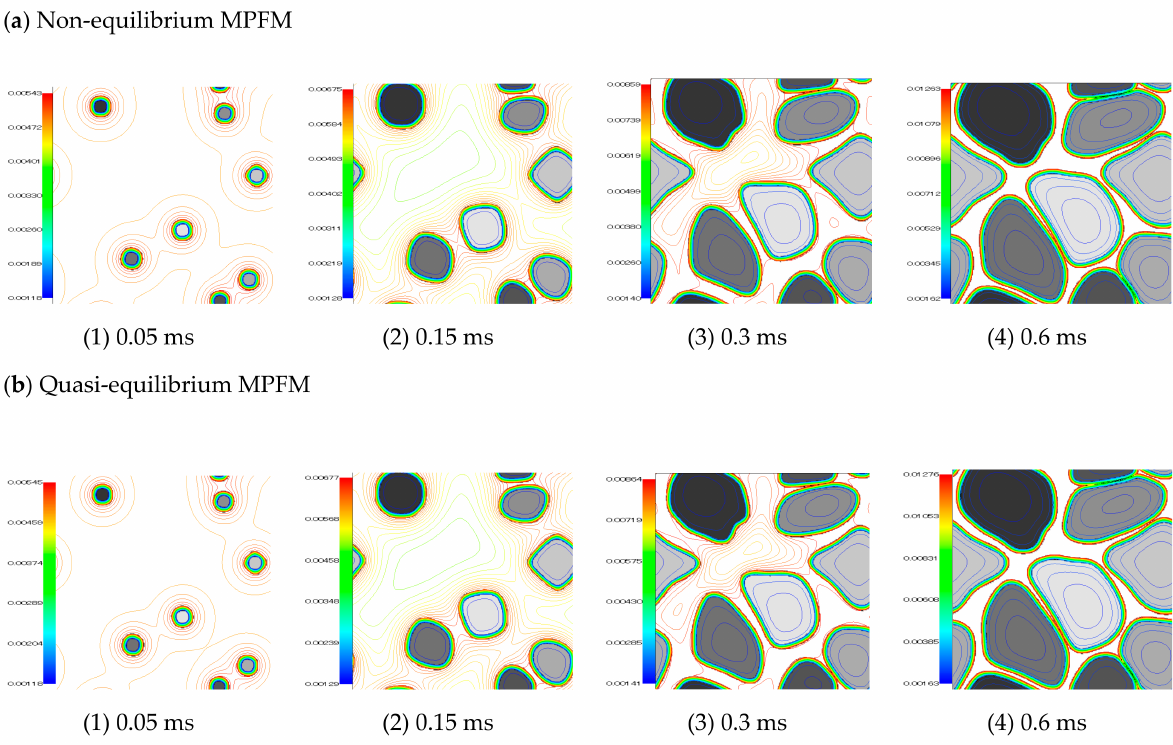
Figure 3. Temporal C concentration (molar fraction) and γ grain distributions obtained at a cooling rate of 10 5 K/s by ( a ) the non-equilibrium MPFM and ( b ) the quasi-equilibrium MPFM.